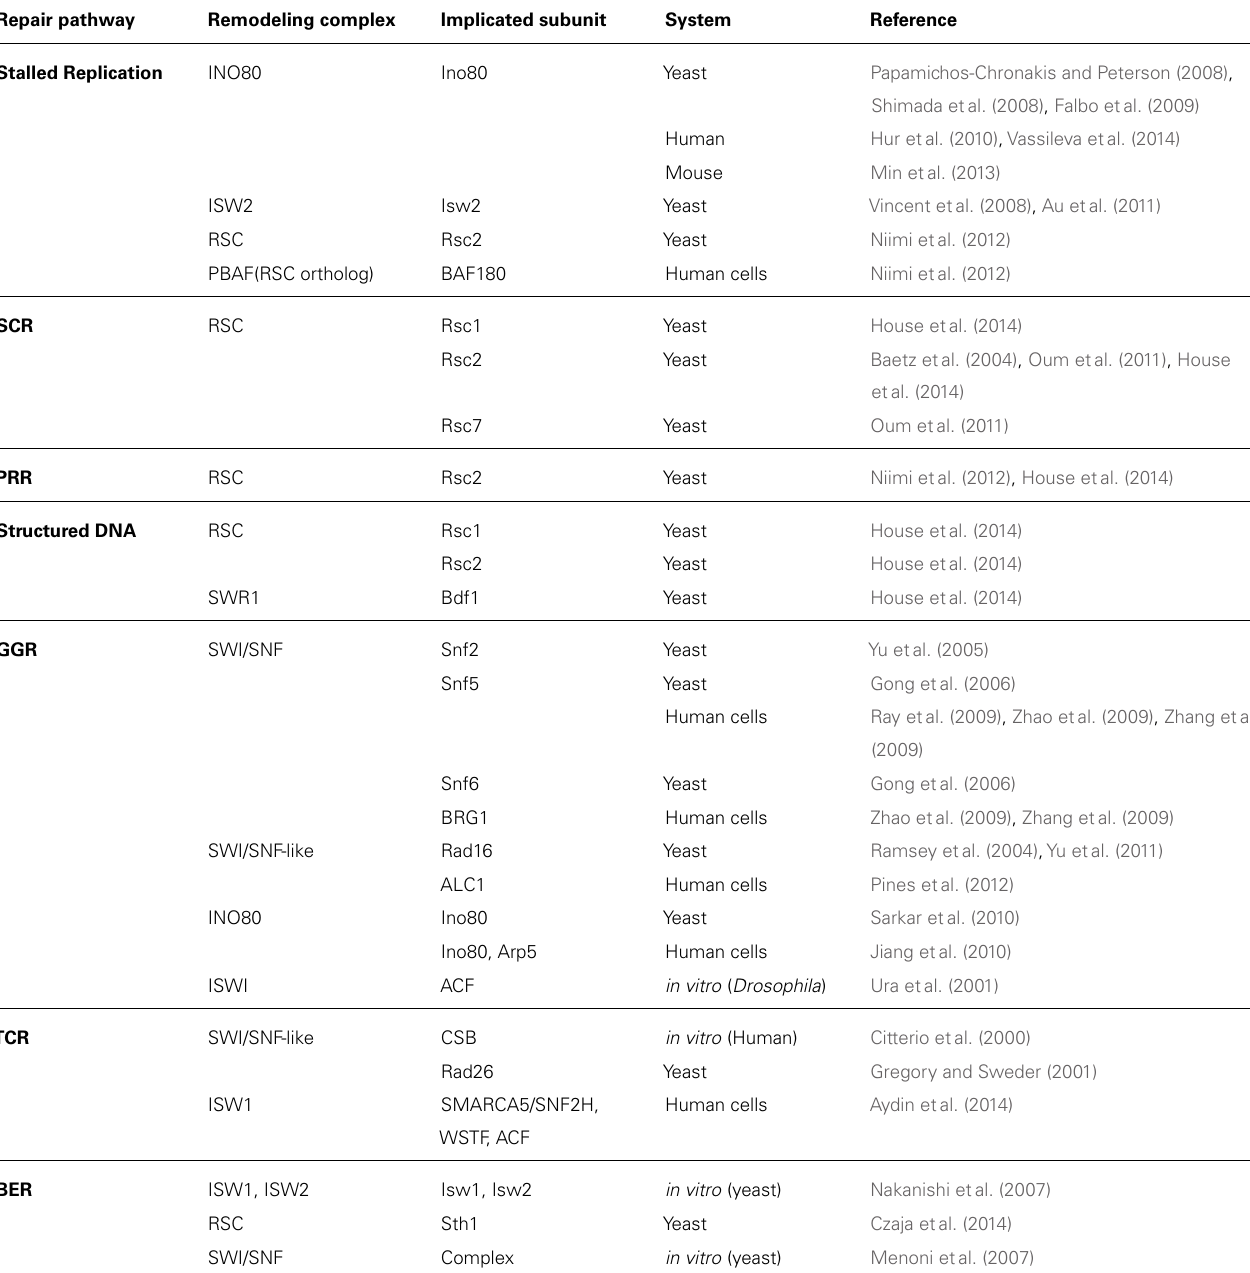
Table 1 | Chromatin remodelers associated with repair pathways outside of DSB repair. Repair